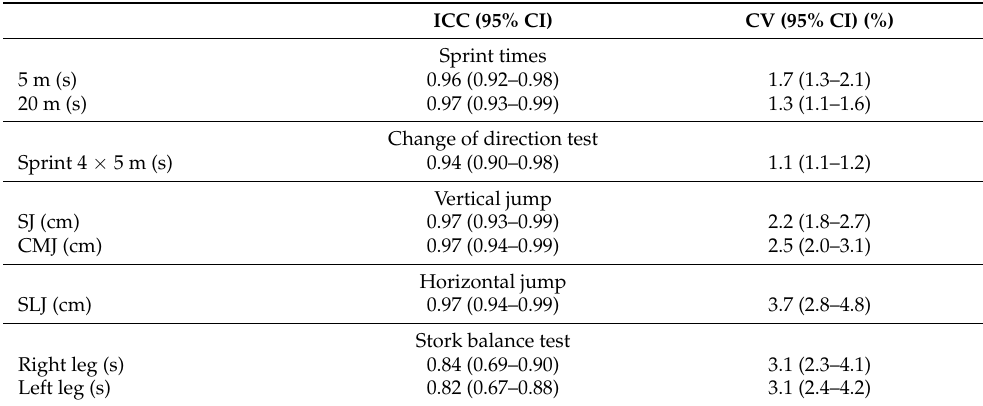
Table 3. Interclass correlation coefficient (ICC, 95% confidence intervals (95% CI)) and coefficient of variation (CV) showing acceptable reliability for all performance